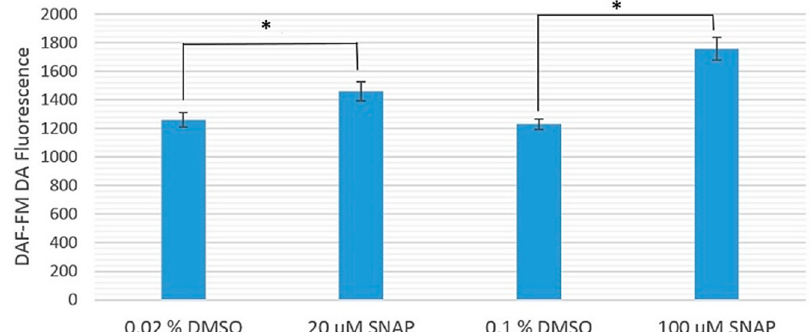
Figure 1. Comparison between the diaminofluorophore 4-amino-5-methylamino-2 ′ -7 ′ -difluorofluorescein diacetate (DAF-FM DA) fluorescence intensities (in arbitrary units; larger values corresponding to brighter fluorescence) in zebrafish embryos treated with 20 or 100 μ M S-nitroso- N -acetylpenicillamine (SNAP) and their corresponding experimental controls treated with 0.02% or 0.1% dimethyl sulfoxide (DMSO), respectively. All experiments were carried out in triplicate on different days, and each set consisted of 15 examined zebrafish embryos. The data were shown as mean DAF-FM DA fluorescence intensities ± standard error of the mean (SEM). Cases with p < 0.05 are asterisked.